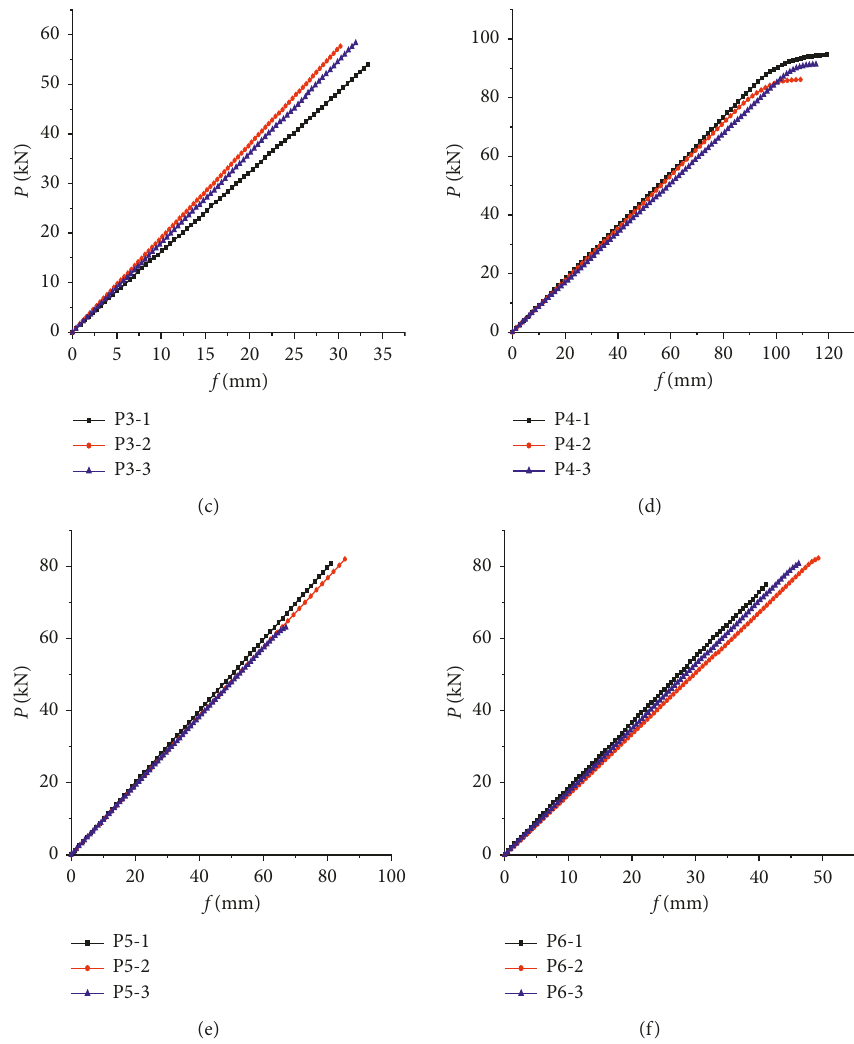
Figure 3: Load-deflection curves. (a) Specimen P1. (b) Specimen P2. (c) Specimen P3. (d) Specimen P4. (e) Specimen P5. (f) Specimen